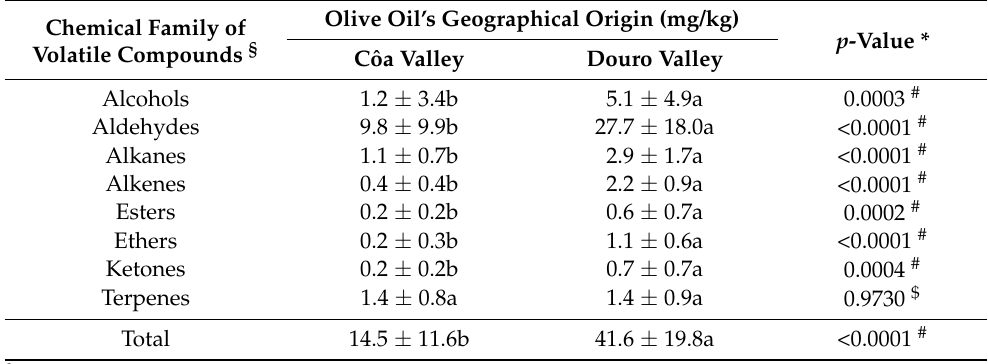
Table 3. Mean content ( ± standard deviation; mg of compound as internal standard equivalents per kg of olive oil) of the chemical classes of volatile compounds detected by gas chromatography (HS-SPME-GC-MS) in olive oils from the two adjacent regions (C ô a: 36 oils; and, Douro: 31 oils). Olive Oil’s Geographical Origin (mg/kg) Chemical Family of p -Value * Volatile Compounds § C ô a Valley